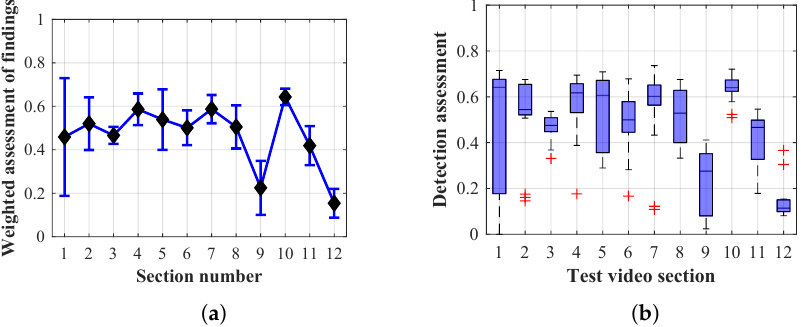
Figure 37. Results of Method 2.1 with a lifespan of 12 frames. ( a ) the weighted average rating with the average mean absolute error of the weighted rating and ( b ) boxplots of the distribution of the statistical sets of the results of the individual sections evaluated indicating: minimum, 1st quartile, median, 3rd quartile,